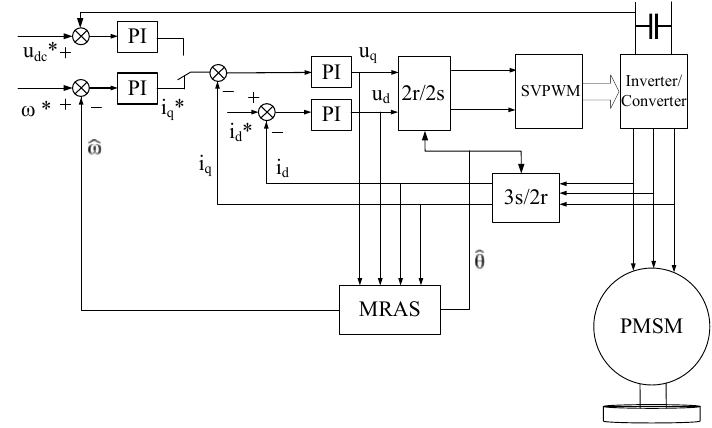
Fig. 14. FESS charging and discharging control block diagram based on